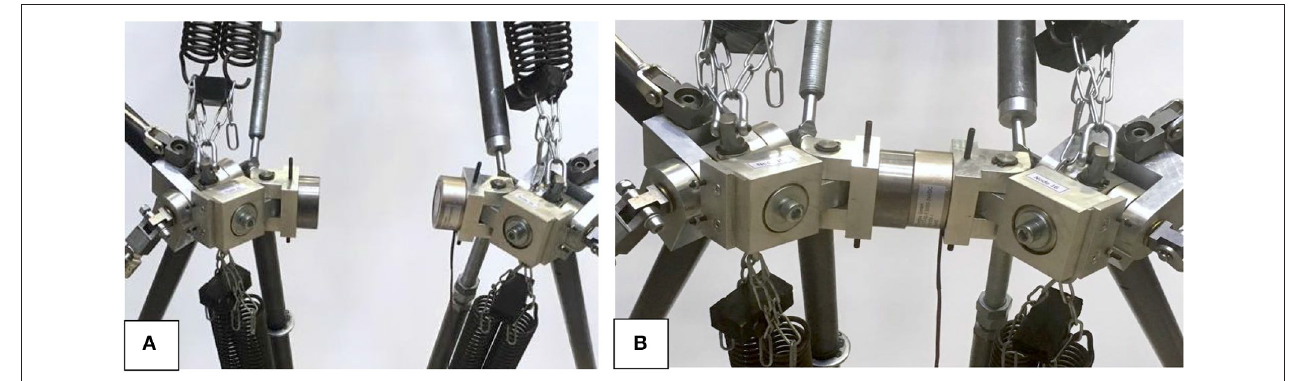
FIGURE 4 | Electromagnets at end-nodes of the tensegrity structure halves prior to midspan connection (A) and after midspan connection (B) .